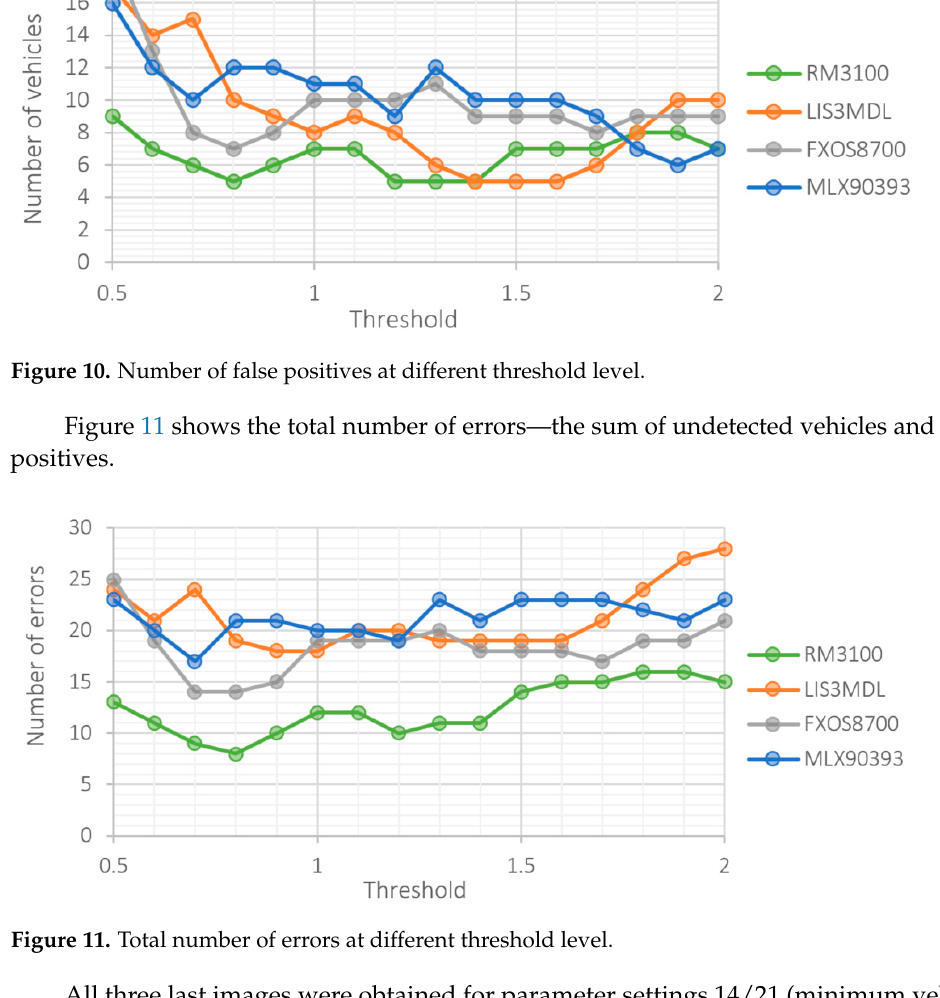
Table 6. Optimal threshold level and detection results for measurement 1.